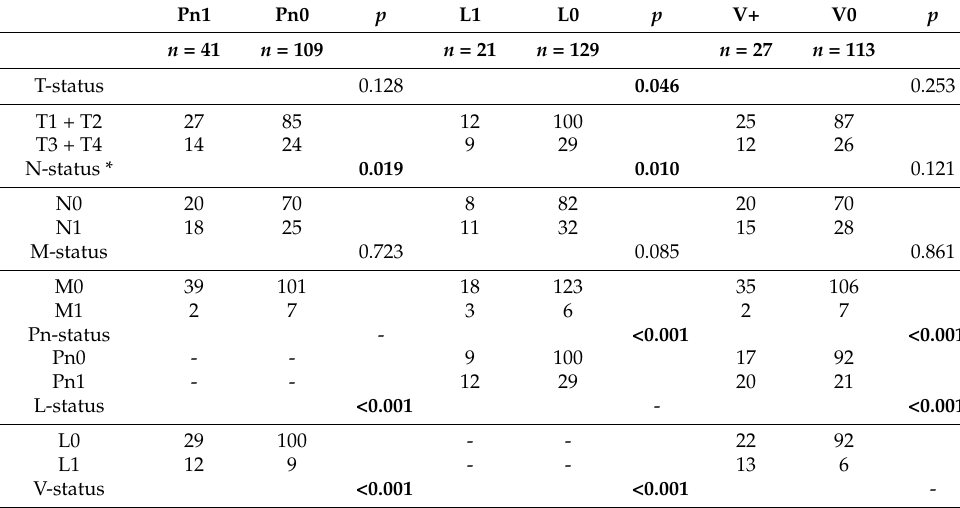
Table 1. Factors associated with perineural, lymphatic, and venous infiltration.